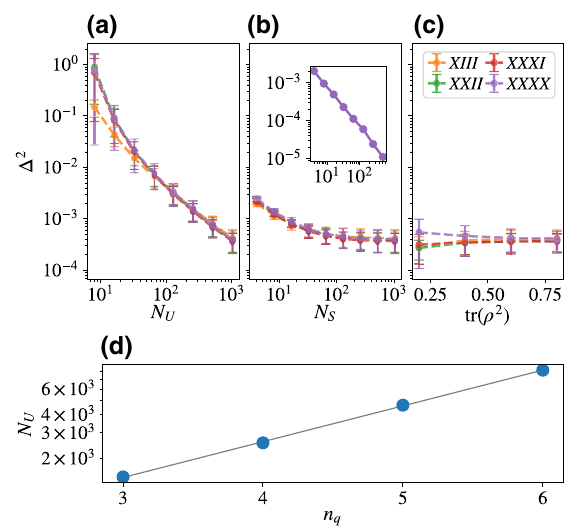
FIG. 2. Scaling of the mean squared error (cid:5) 2 for n q = 4 qubits and error strength ε = 0.1: (a) the number of unitaries N U with a fixed number of shots N S = 1024; (b) the number of shots with a fixed N U = 1024. The inset shows the convergence to the final value with N S . (c) The scaling of (cid:5) 2 with purity, tr (ρ 2 ) , for N S = N U = 1024. The legend indicates the choices for O [see Eq. (5)] in panels (a)–(c). Error bars are standard deviations of (cid:5) 2 over 100 random states. (d) The number of bases N U in order to reach mean squared error (cid:5) 2 versus the number of qubits n q for N S = 1. The solid lines are fitting curves N U = c 2 γ n q . For (cid:5) = 0.01, γ =